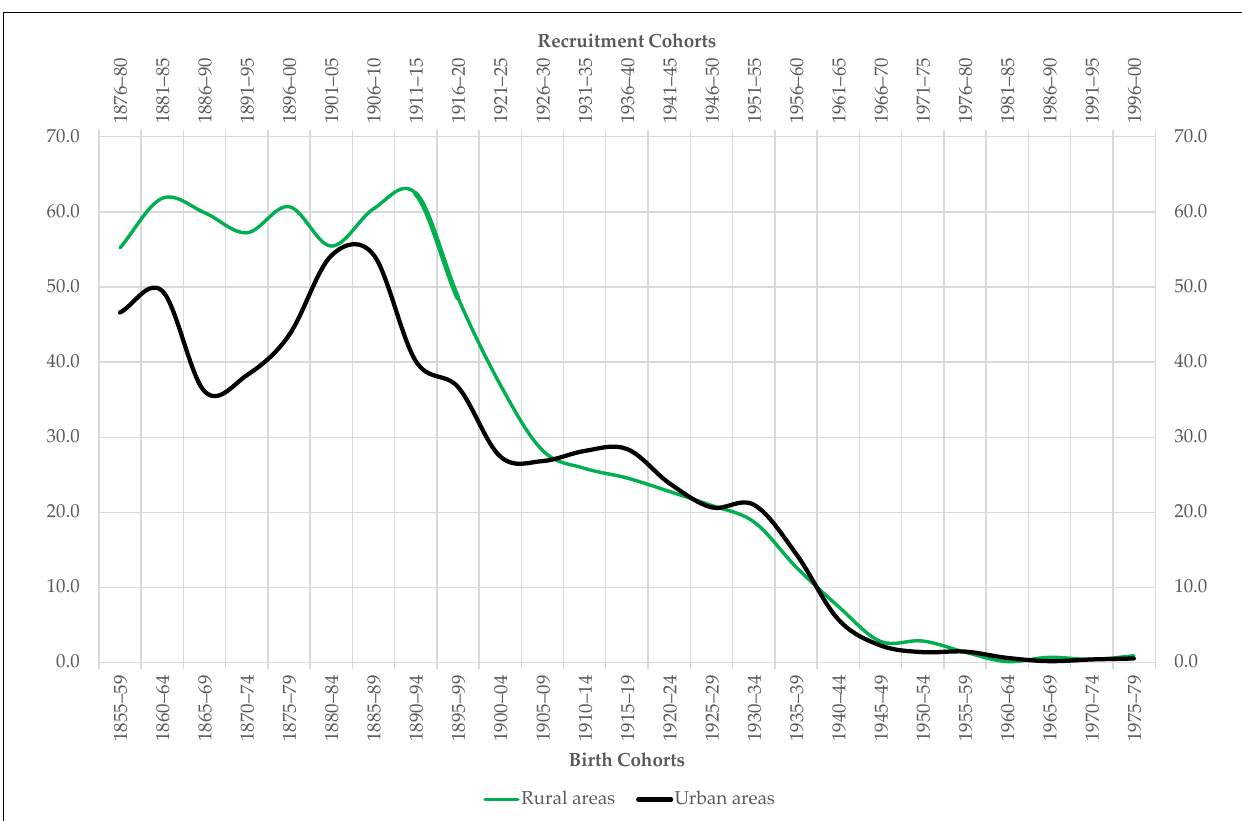
Figure 8. Proportion of recruits included in the sample Extremadura who declare to be illiterate (percentage over the total recruits presented for conscription).